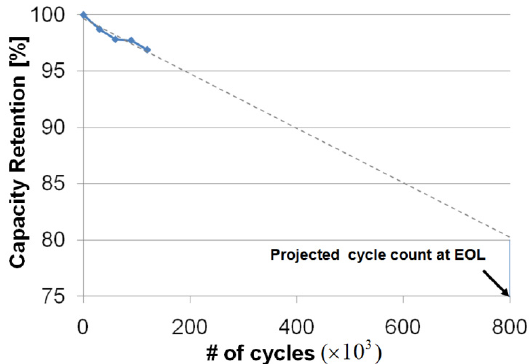
Figure 8. An actual experiment result for the CS cycles with SK Innovation’s commercialized 15 Ah PHEV cell. The dashed line indicates extrapolated cycle count at the end-of-life of the